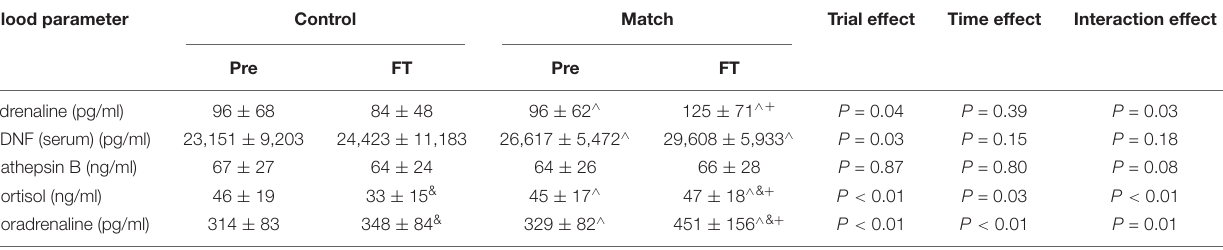
TABLE 4 | Blood parameter (mean ± SD) across the control and match day trials. Blood parameter Control